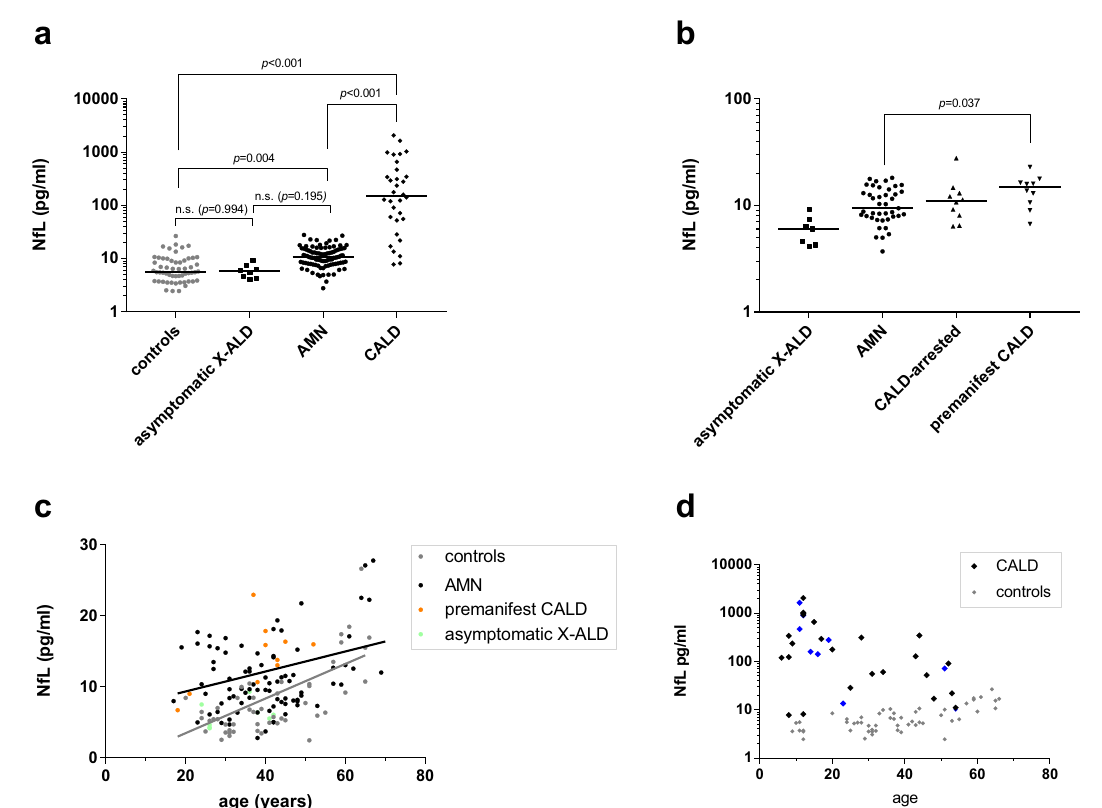
Fig. 1 NfL levels in X-ALD patients. a NfL in plasma and serum samples of asymptomatic X-ALD patients ( n = 7, median age = 31 years, total sample number = 8), non-in fl ammatory AMN ( n = 61, median age = 40 years, total sample number = 93), in fl ammatory CALD ( n = 24, 13